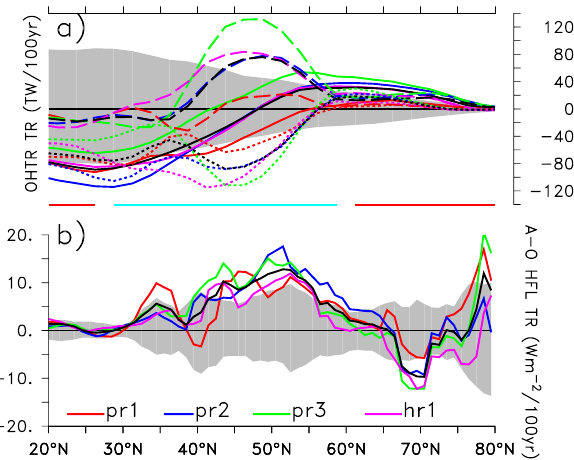
Figure 5. Simulated 20th-century linear trends (1905–2005) as zonal averages over the Atlantic Basin (experiments pr1, pr2, pr3, and hr1 as indicated by coloured lines; black lines indicate ensem- ble means): (a) (solid lines) TOHTR, (dashed lines) GOHTR, and (dotted lines) MOHTR. Light-blue and red horizontal lines at the bottom of the plot indicate regions where the ensemble-mean TO- HTR divergence is positive (cooling by lateral advection: light-blue) or negative (warming by lateral advection: red). (b) Atmosphere– ocean heat fluxes. Positive values indicate increased heat transfer from the atmosphere to the ocean or cooling of the atmosphere by the ocean. Coloured lines are individual simulations, and the black line is the ensemble mean. In (a) and (b) , the grey-shaded regions indicate the 5th–95th-percentile ranges of centennial trends in the unperturbed PiCtrl